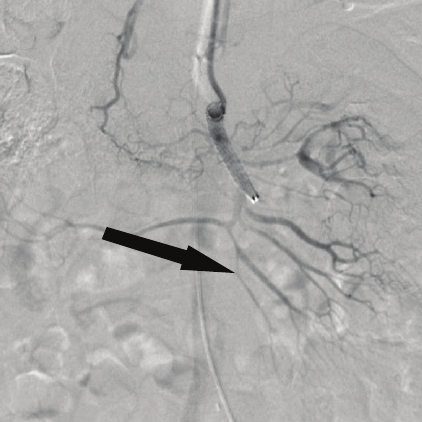
Figure 2: Angiography shows occlusion of the SMA with missing branches.